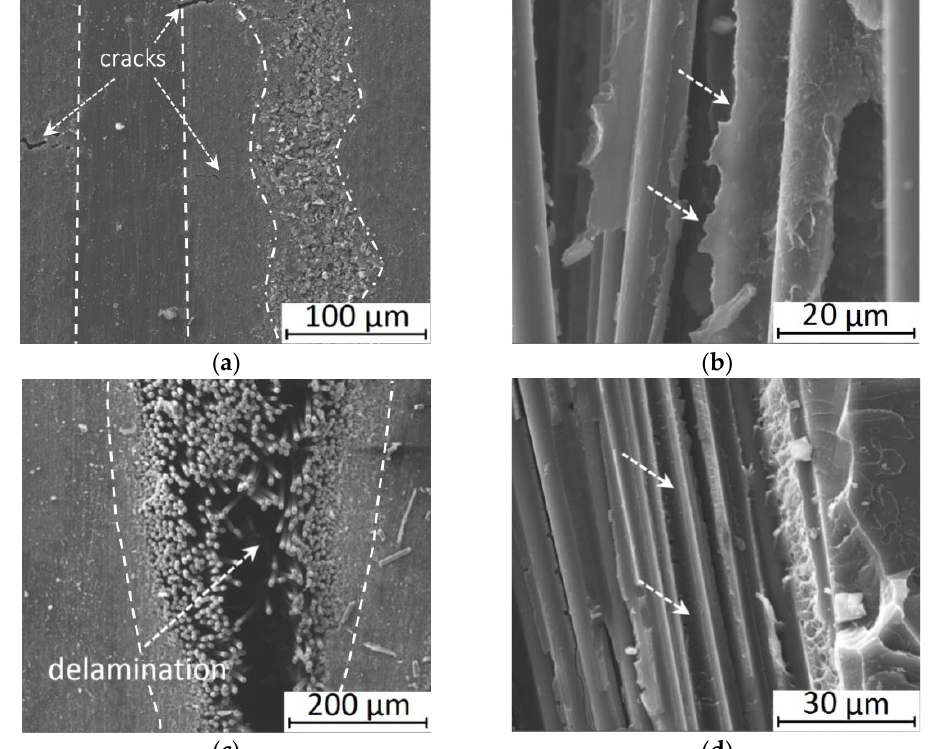
Figure 8. SEM micrographs of the composite structures. Interlayer level: PEEK/CF ( a ), PI/CF ( c ). Interfacial level: PEEK/CF ( b ), PI/CF ( d ).